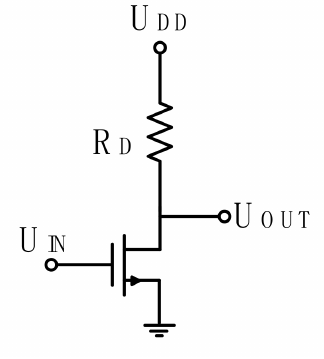
Figure 6. CS amplifier circuit schematic diagram.